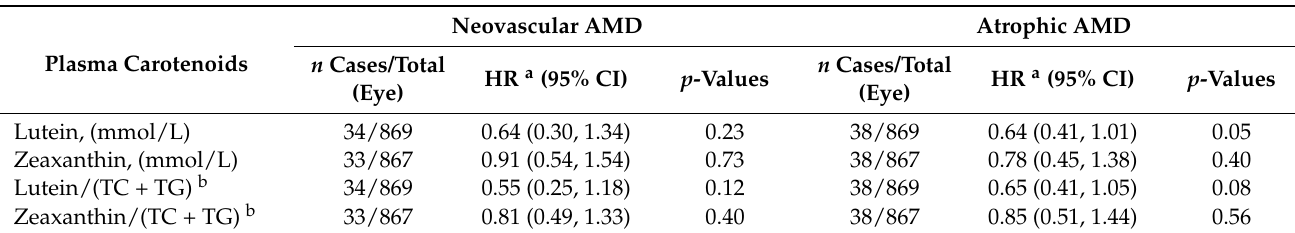
Table 3. Associations between plasma lutein, zeaxanthin, and their (TC + TG) ratios and incidence of neovascular and atrophic age-related macular degeneration. Alienor study, 2006–2017.